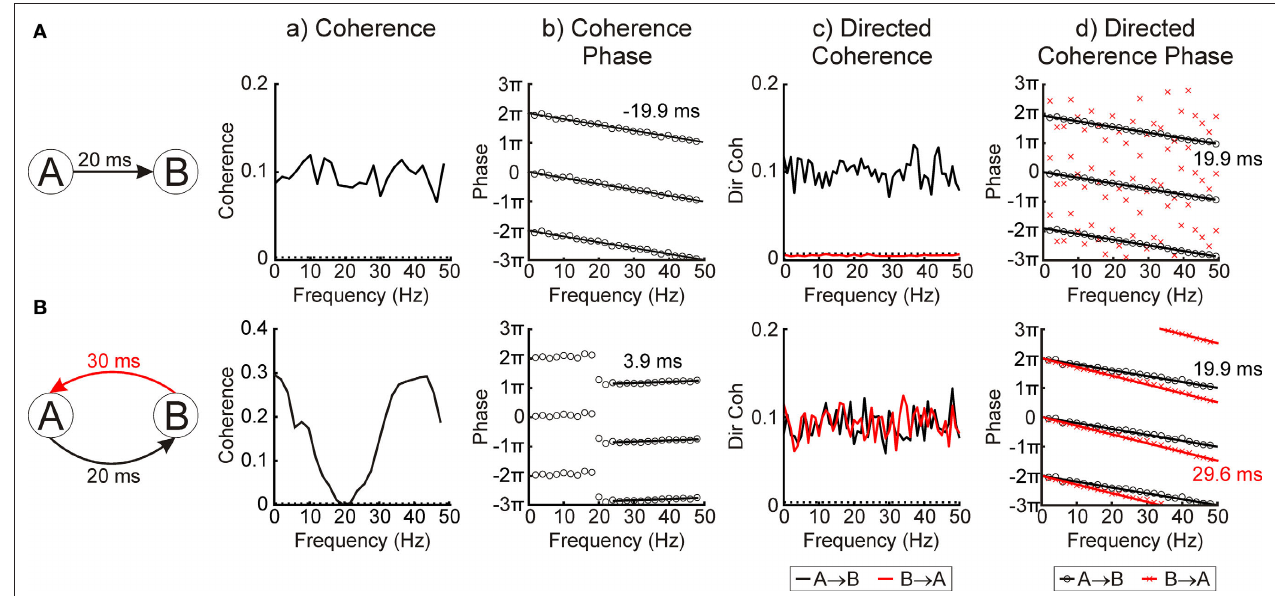
Figure 1 | using directed coherence to determine bi-directional coupling and delays. (A) coherence and directed coherence analysis of two simulated white band signals with uni-directional coupling (A → B with a 20-ms delay). (B) coherence and directed coherence analysis of two simulated white band signals with bi-directional coupling (A → B with a 20-ms delay and B → A with a 30-ms delay). (a) coherence spectra. Dotted lines show 95% significance level.